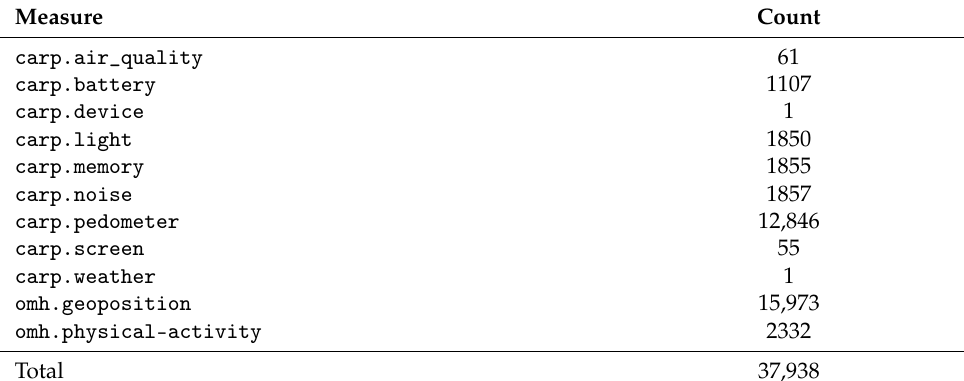
Table 1. Number of collected measures.